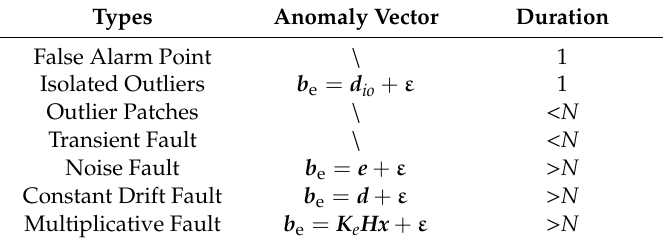
Table 1. The anomaly vectors of several typical